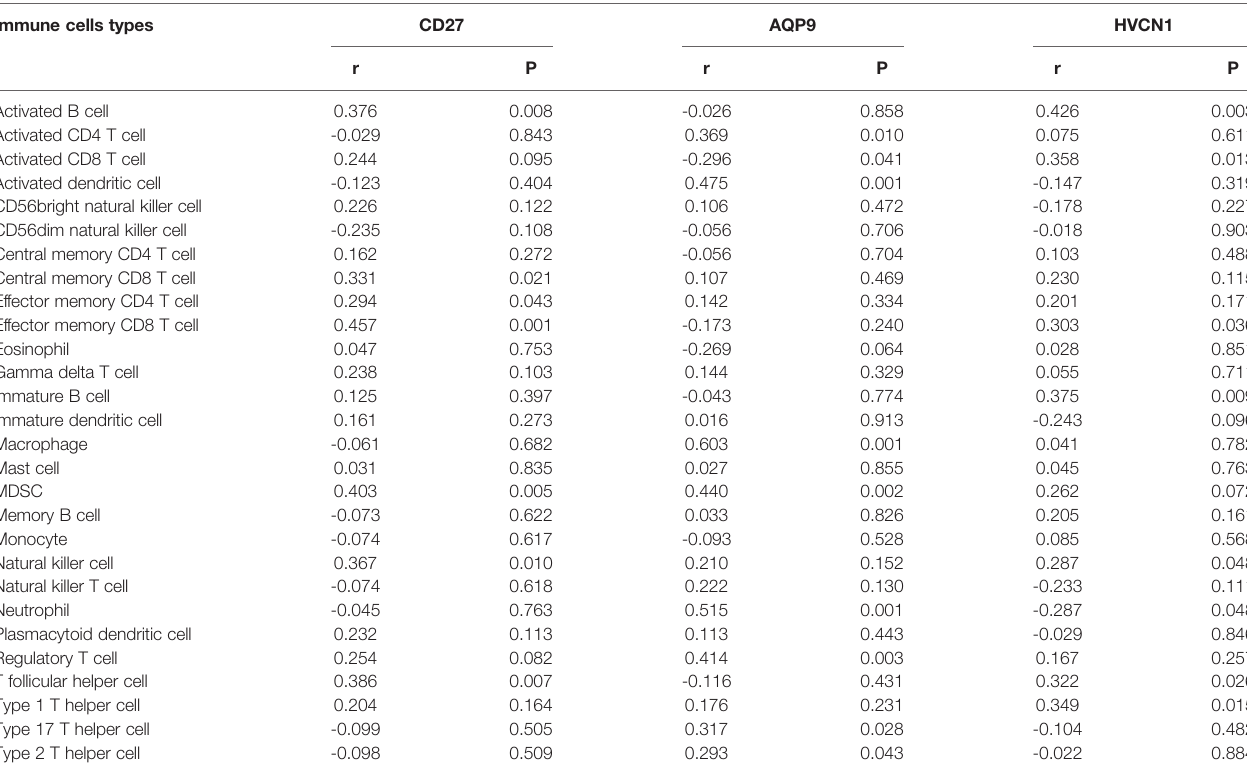
TABLE 2 | Correlation of AQP9, CD27, HVCN1 with immune cells in CD. Immune cells types